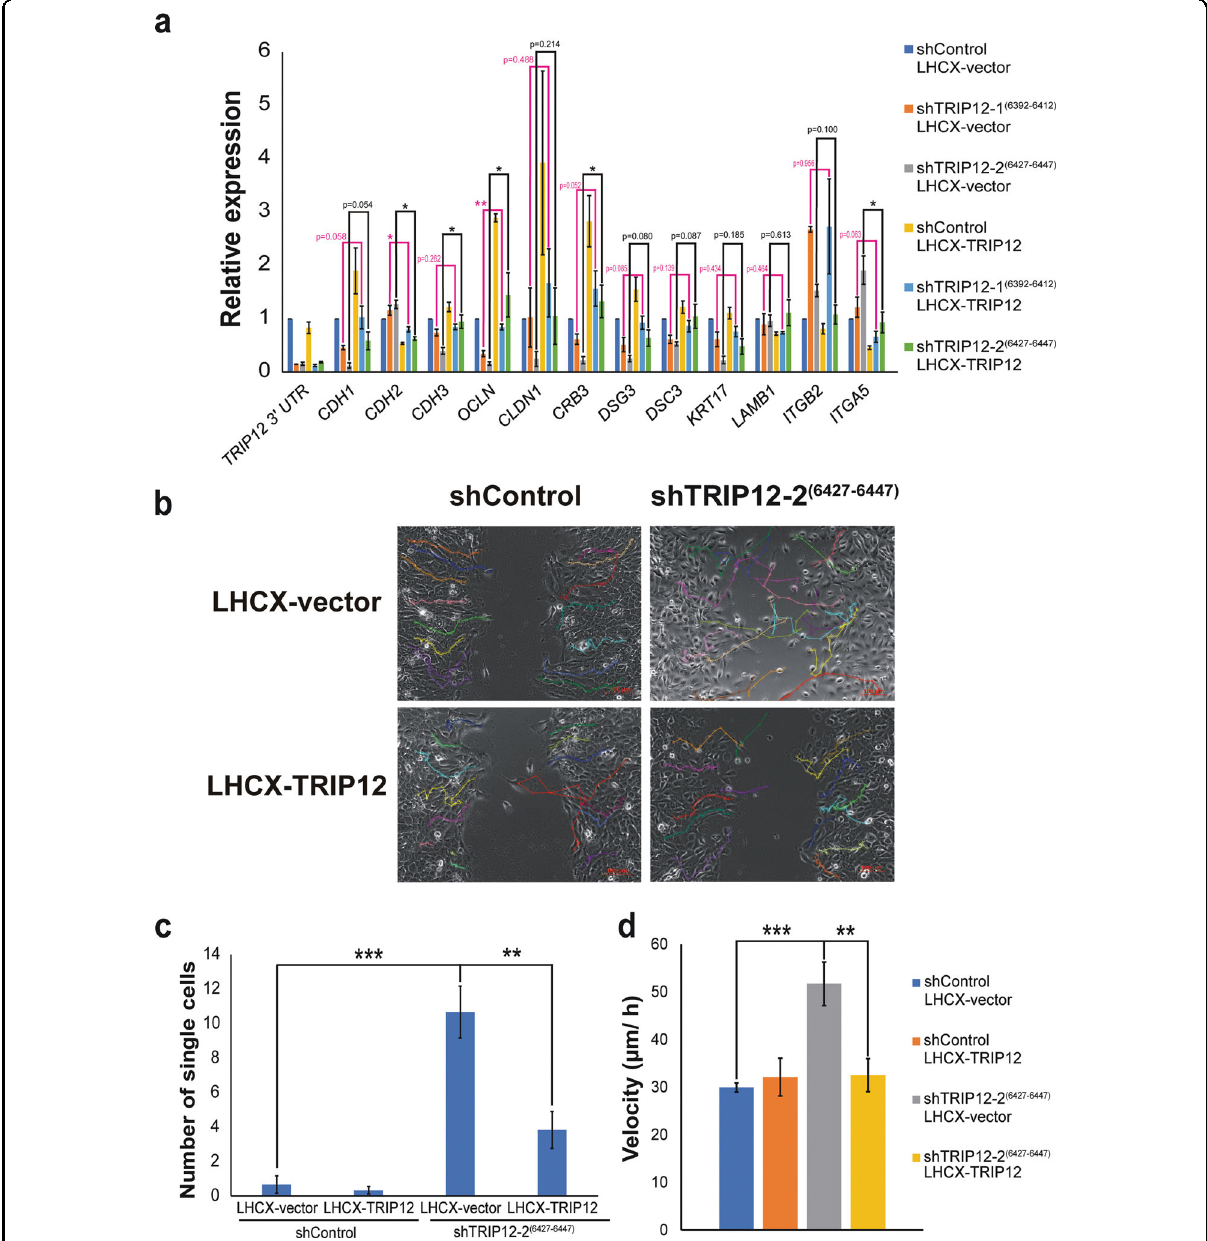
Fig. 4 Alterations in TRIP12 level results in loss of cellular polarity, increase in single-cell dislodgment, increase in cell motility, and sensitivity to anoikis. a Relative expression of the mRNA levels of EMT markers in MCF10A cells stably depleted of TRIP12 and with LHCX-vector expression or LHCX-TRIP12 expression. Relative expression levels were normalized to Actin mRNA levels and data quanti fi ed relative to shControl LHCX vector. ( N = 3). Data represent means ± SEM. * p value < 0.05; ** p value < 0.01. b Representative cell tracking snapshot images of cell migration/ wound-healing assay for MCF10A shControl and shTRIP12-2 (6427 – 6447) , with either LHCX-vector or LHCX-TRIP12 expression, at midpoint to wound closure. Fifteen single cell tracks are represented with different colors in each image. Images were taken at 10X magni fi cation. The scale bar at bottom right corner = 100 µm. c Quanti fi cation of the number of single cells in the remaining wound area from images when the remaining wound area is 35 – 55% of the total area. ( N = 6). Data represent means ± SEM. ** p value < 0.01; *** p value < 0.001. d Velocity of tracked MCF10A shControl and shTRIP12-2 (6427 – 6447) , with either LHCX-vector or LHCX-TRIP12 expression. Fifteen cell tracks per condition were used for acquiring velocity data. Data represent means ± SEM. ** p value < 0.01; *** p value <